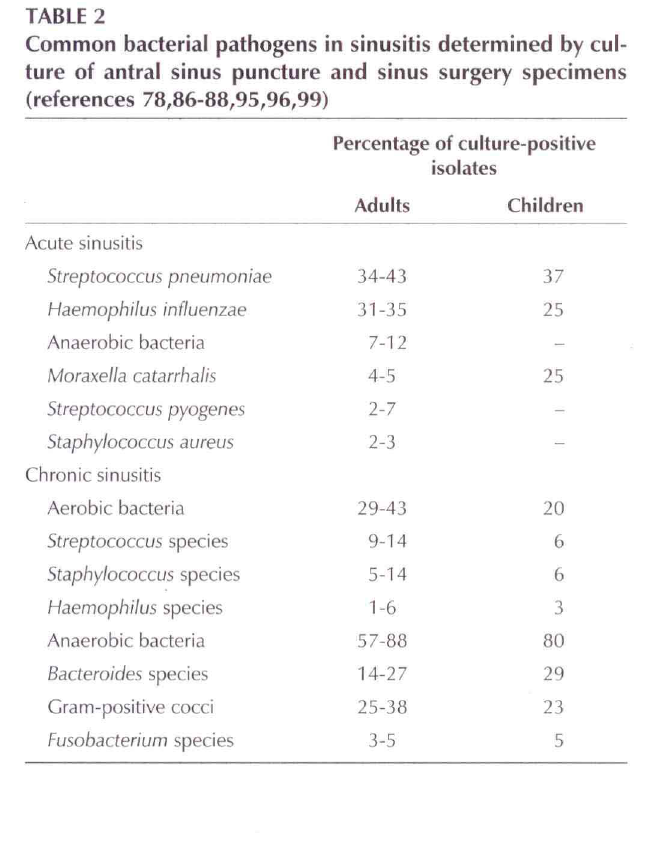
Common bacterial pathogens in sinusitis determined by cul ture of antral sinus puncture and sinus surgery